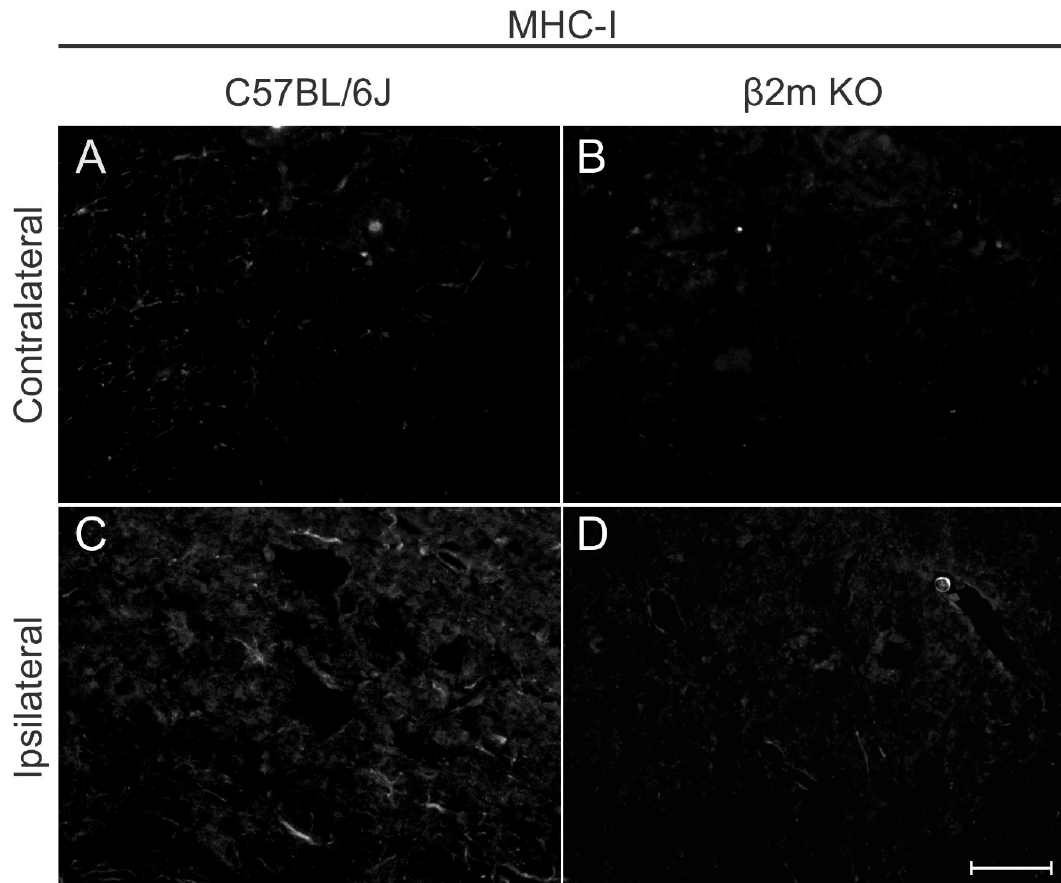
Figure 9. Major histocompatibility complex of class I (MHC-I) expression in C57BL/6J ( A and C ) and β 2mKO mice ( B and D ) 7 days after VRC. Note that contralateral labeling is almost absent in C57BL/6J showing upregulation after injury. β 2mKO mice showed weak staining both in the contra and ipsilateral sides. Scale bar = 25 μ m.